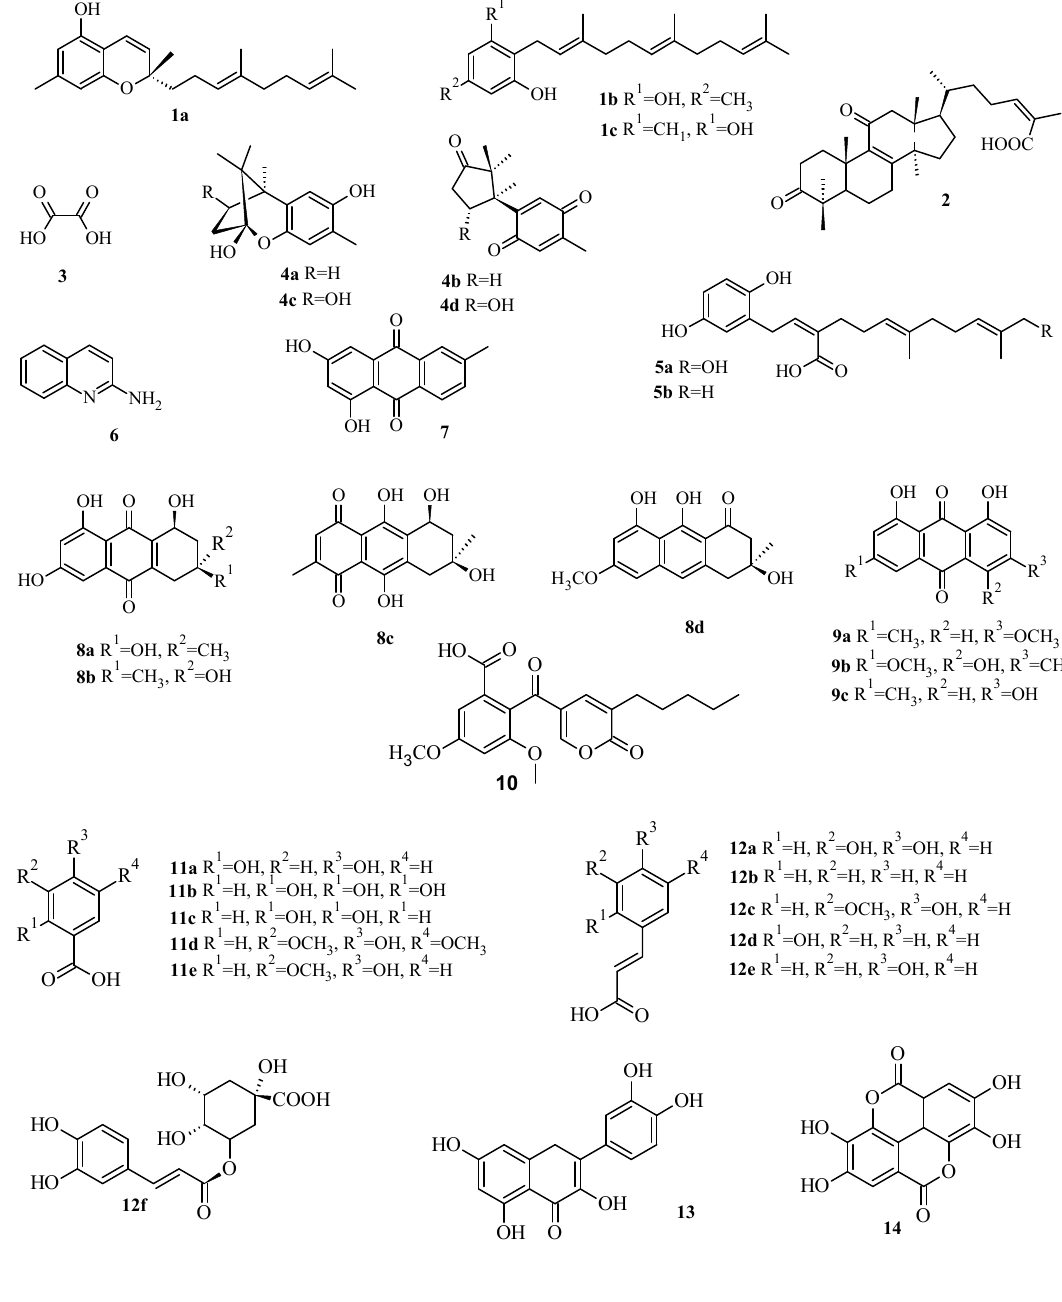
Figure 1. Chemical structures of the mushroom compounds pointed out as antimicrobial